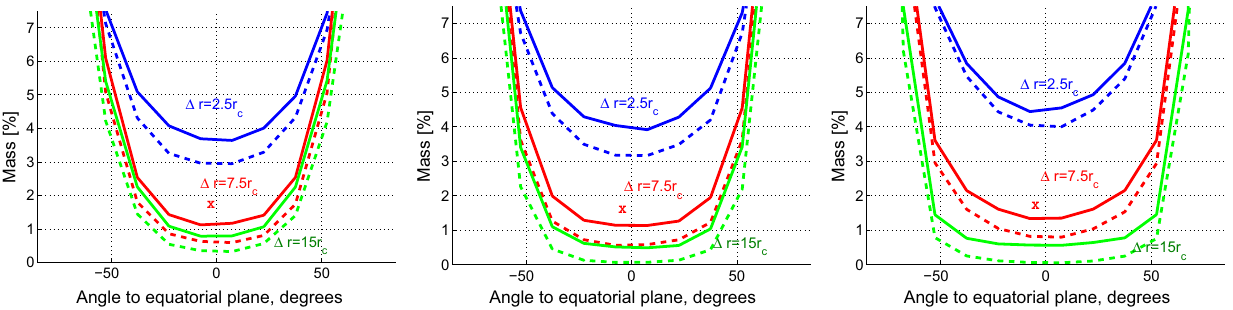
Fig. 9 The plots of the mass contained in projected mass density maps in 15 ◦ degree sectors centered on the collision’s center, as a function of the angle to the collision’s equatorial plane, and shown as the per- centile of the total density map’s mass. Shown are the respective plots forearly( (cid:5) r = 2 . 5 r c ),intermediate( (cid:5) r = 7 . 5 r c )andlate( (cid:5) r = 15 r c )